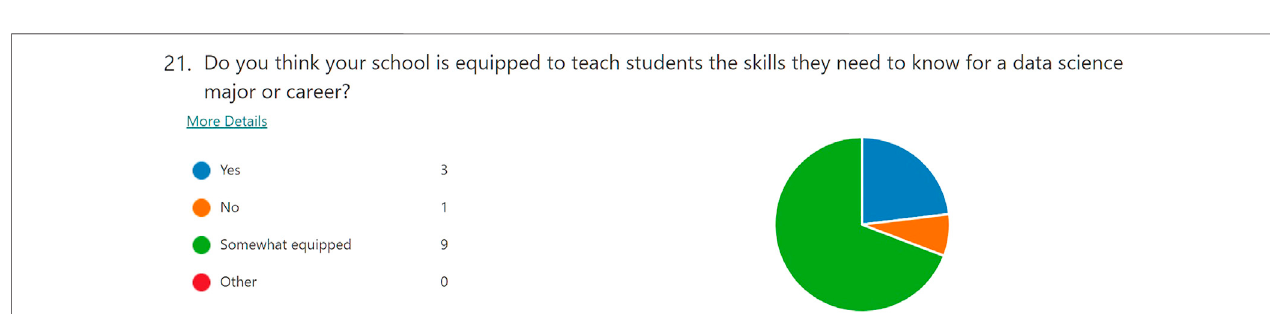
FIGURE 3 | Teacher Responses to the question asking about school